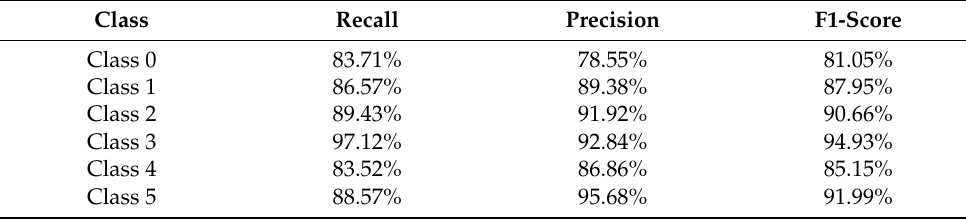
Table 4. The results per class of the facial gesture recognition system.